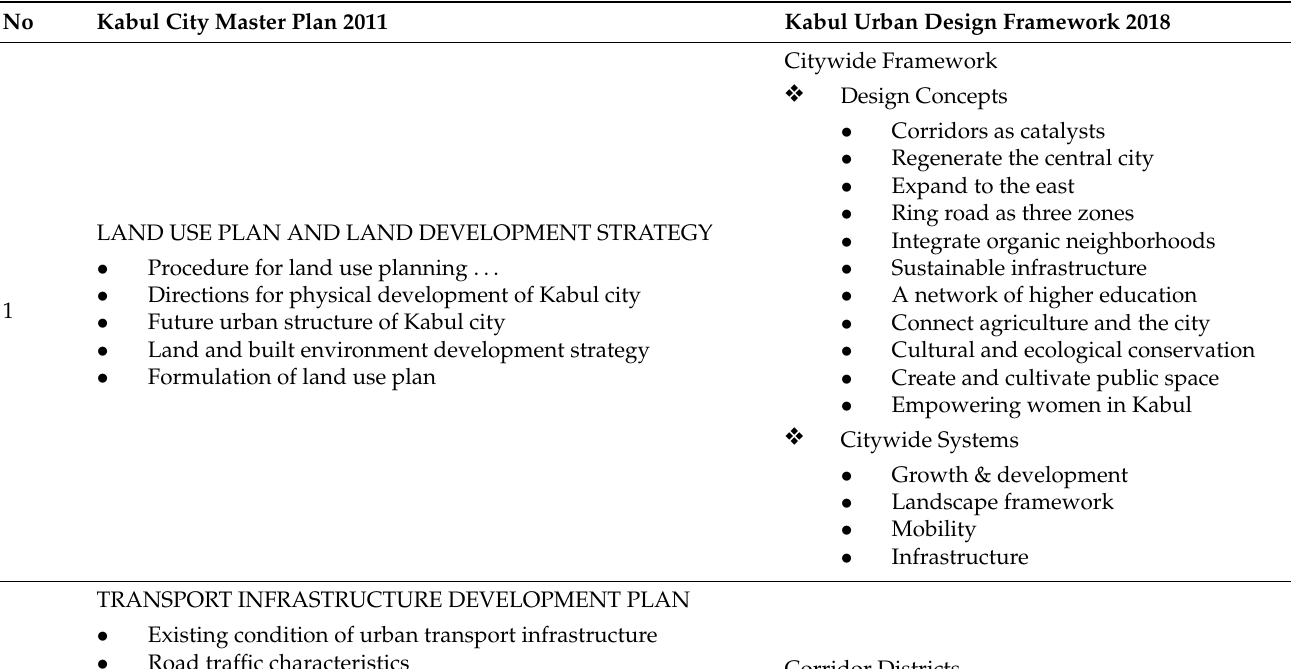
Table 2. Japan International Cooperation Agency (JICA) 2011, and Kabul Urban Design Framework 2018 Master Plans Chapters.